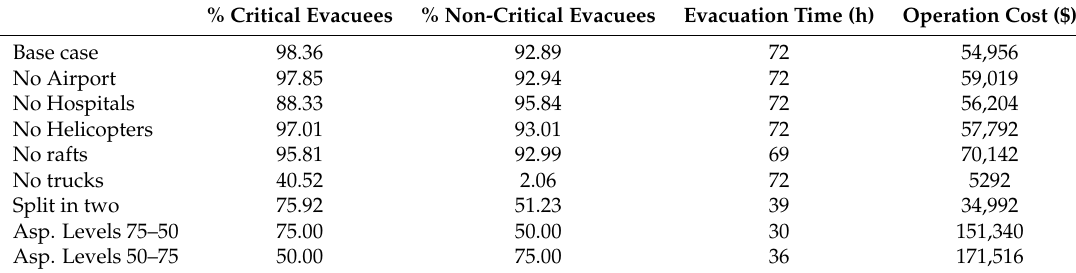
Table 7. Results of the case